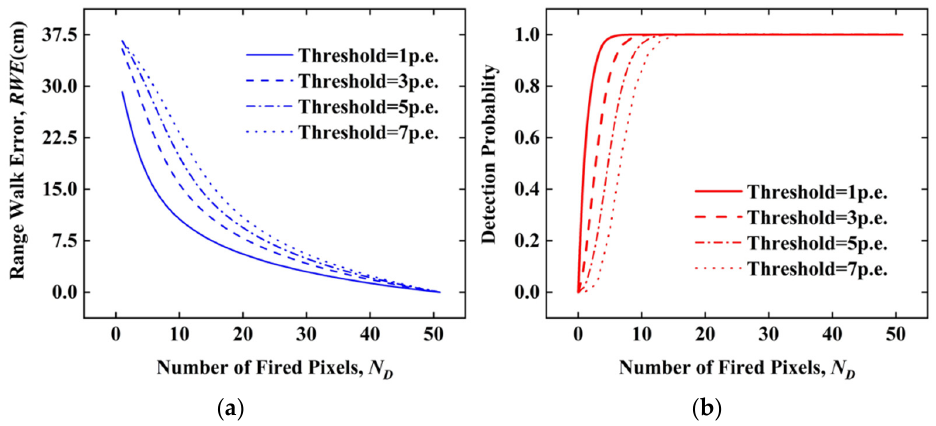
Figure 3. ( a ) Simulation result between RWE and mean number of fired pixels with different thresh- olds. ( b ) Detection probability between fired pixels with different thresholds. olds. ( b ) Detection probability between fired pixels with different